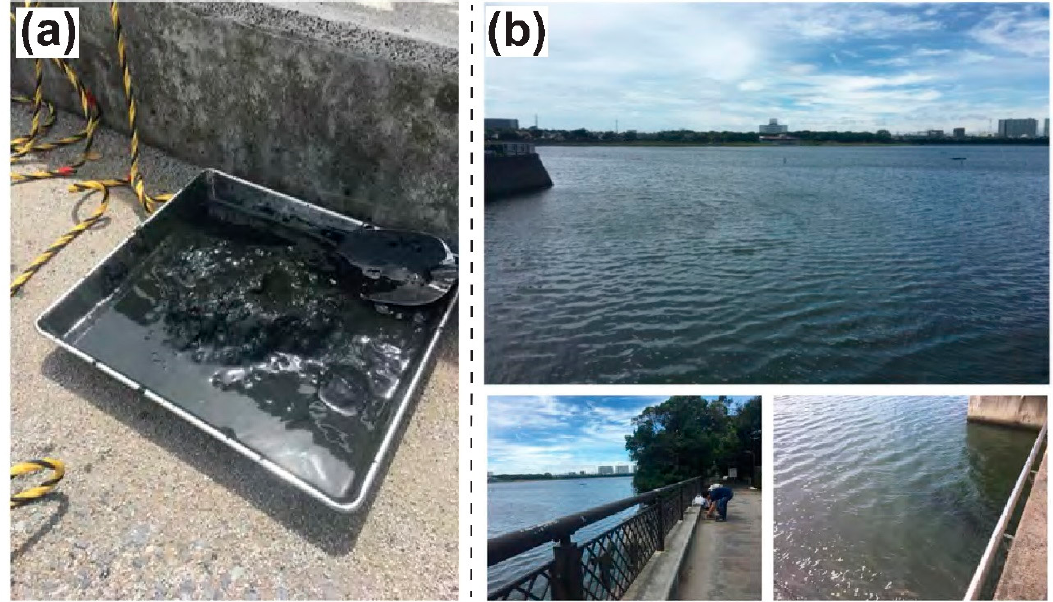
Figure 3. Pictures of the sampling point (Yatsu Tideland, Japan). ( a ) Picture of the sample. ( b ) State of the sampling place. The sample was taken from a bridge, as shown in the picture, using an Ekman–Birge